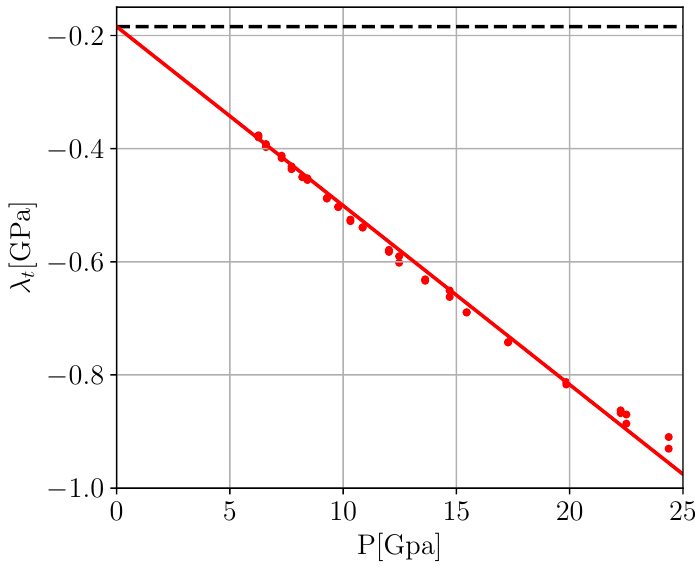
Figure 10. Results of minimizing the sum (40) using the relative weights ( w a , w t ) = ( 10,1 ) and pressure parameters P 0 = 6GPa, d = 40. The dashed horizontal line indicates the limiting value λ t ( P = 0 ) ≡ λ